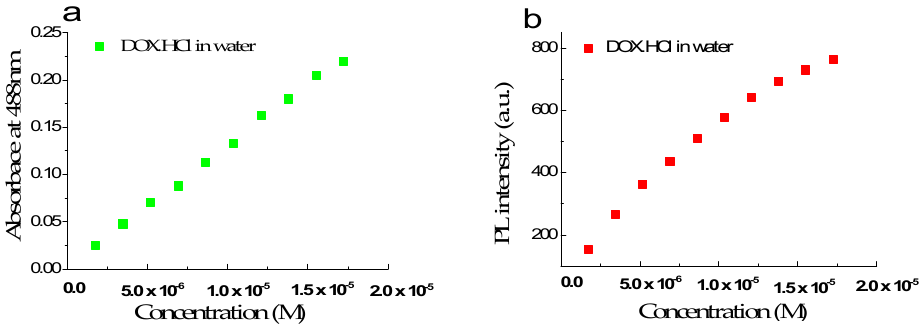
Figure 1. Absorption and fluorescence intensity spectra of free DOX in aqueous solution at 480 nm ( a ) and 595 nm ( b ) with the concentration in the range of 1.72 × 10 − 6 M to 1.72 × 10 − 5 M. Quantum yield (Q.Y.) of free DOX·HCl in aqueous solutions was determined from the data presented in Figure 2 for both absorption and fluorescence measurements. At this concentration range, the OD varies from 0.01 to 0.15. Solution of R6G dye in ethanol was used as the reference sample. From the known value Q.Y. of 94% of the R6G, Q.Y. of free DOX was calculated using the following equation.